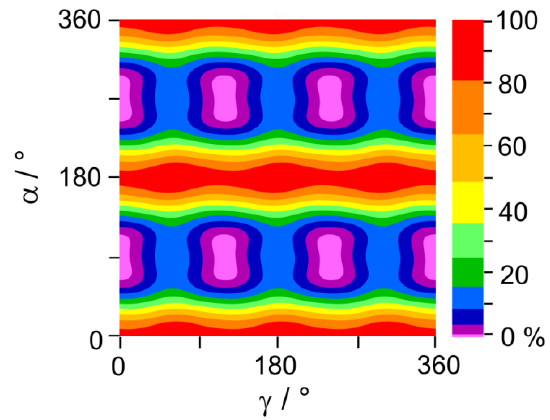
Figure 5. The potential energy surface of phenyl acetate calculated at the MP2/6-311++G(d,p) level of theory in dependence of the dihedral angles α and γ . The energies are given in percentage color code, relative to E min = − 458.9579660 E h (0%), and E max = − 458.9533836 E h (100%). The relative energy of the maximum is about 12 kJ/mol. Note that there are more colors in the lower 50% region.